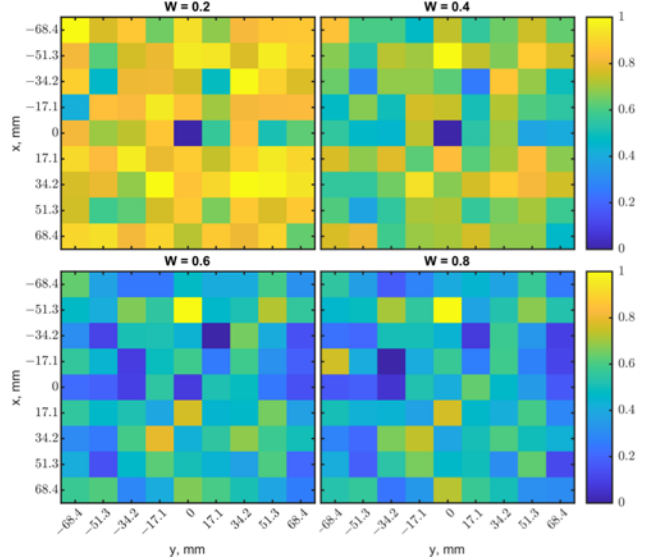
Figure 23. Comparisons of heatmaps fused with normalized results in Figure 22 and with different weighting factors W of 0.2, 0.4, 0.6, and